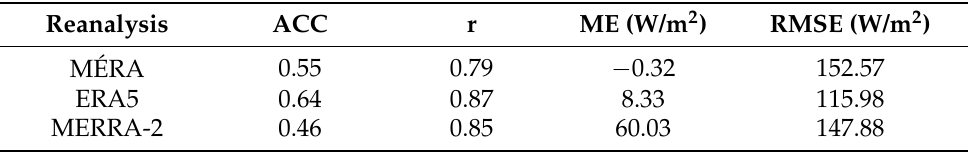
Figure 6. Left : Taylor diagram of 10 m wind speed at all stations (coastal (+) and inland (o)) for ERA5 ( blue ), MÉRA ( green ), and MERRA-2 ( red ). The radial dimension represents the model normalised standard deviations, correlation coefficients are represented in angular coordinates, and the arcs show the normalised centred RMSE (CRMSE). Right : close-up view of the red box in left plot. Table 4. Skill scores of each reanalysis compared to observations: anomaly correlation coefficient (ACC), Spearman’s correlation (r), mean error (ME), and root mean square error (RMSE) for hourly SW averaged over all stations for summer (June, July, and